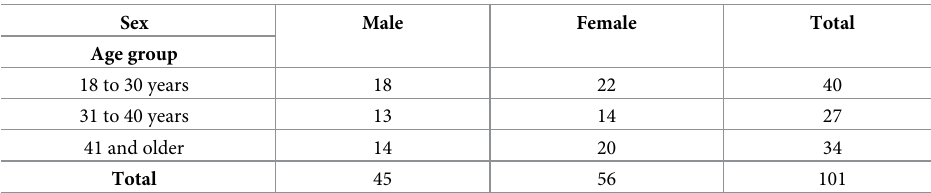
Table 1. Sample distribution by sex and age